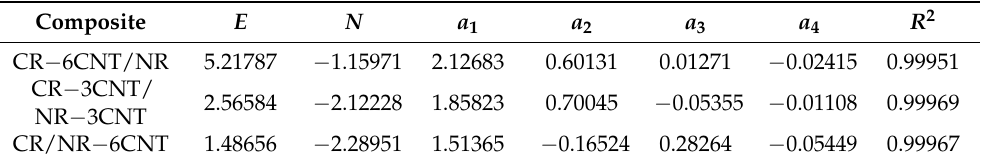
Table 3. The fitting parameters of Equation (17).